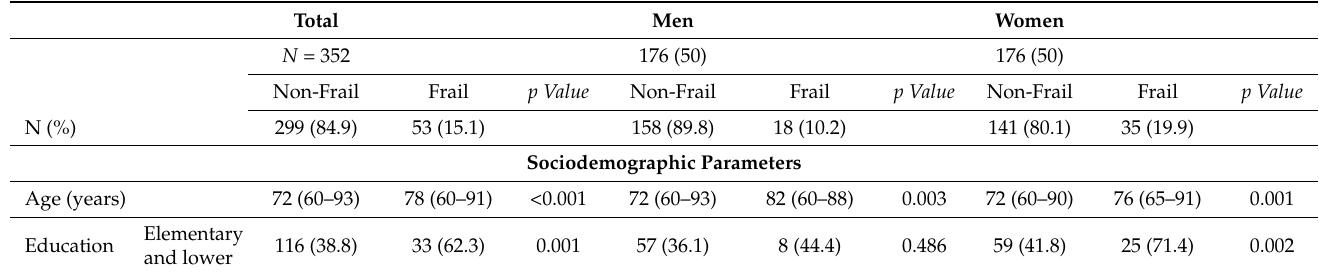
Table 3. Sociodemographic and health-related factors associated with frailty in total sample and stratified by